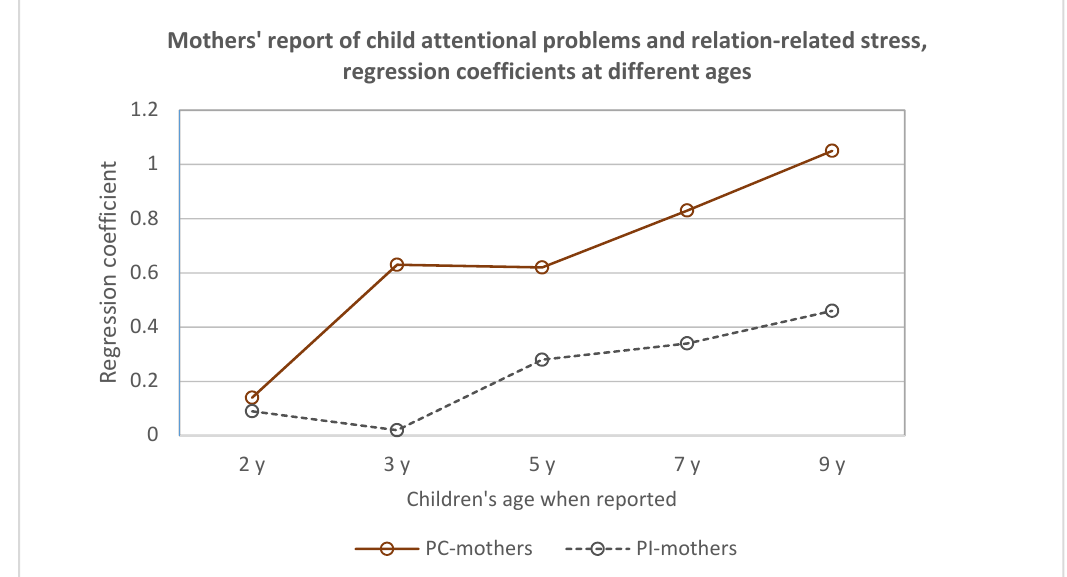
Figure 1. Maternal assessments of child attentional problems and their corresponding ratings of relation-related stress, regression coefficients by group. Regression coefficients computed for each group of mothers on data from each follow-up by simple regression.